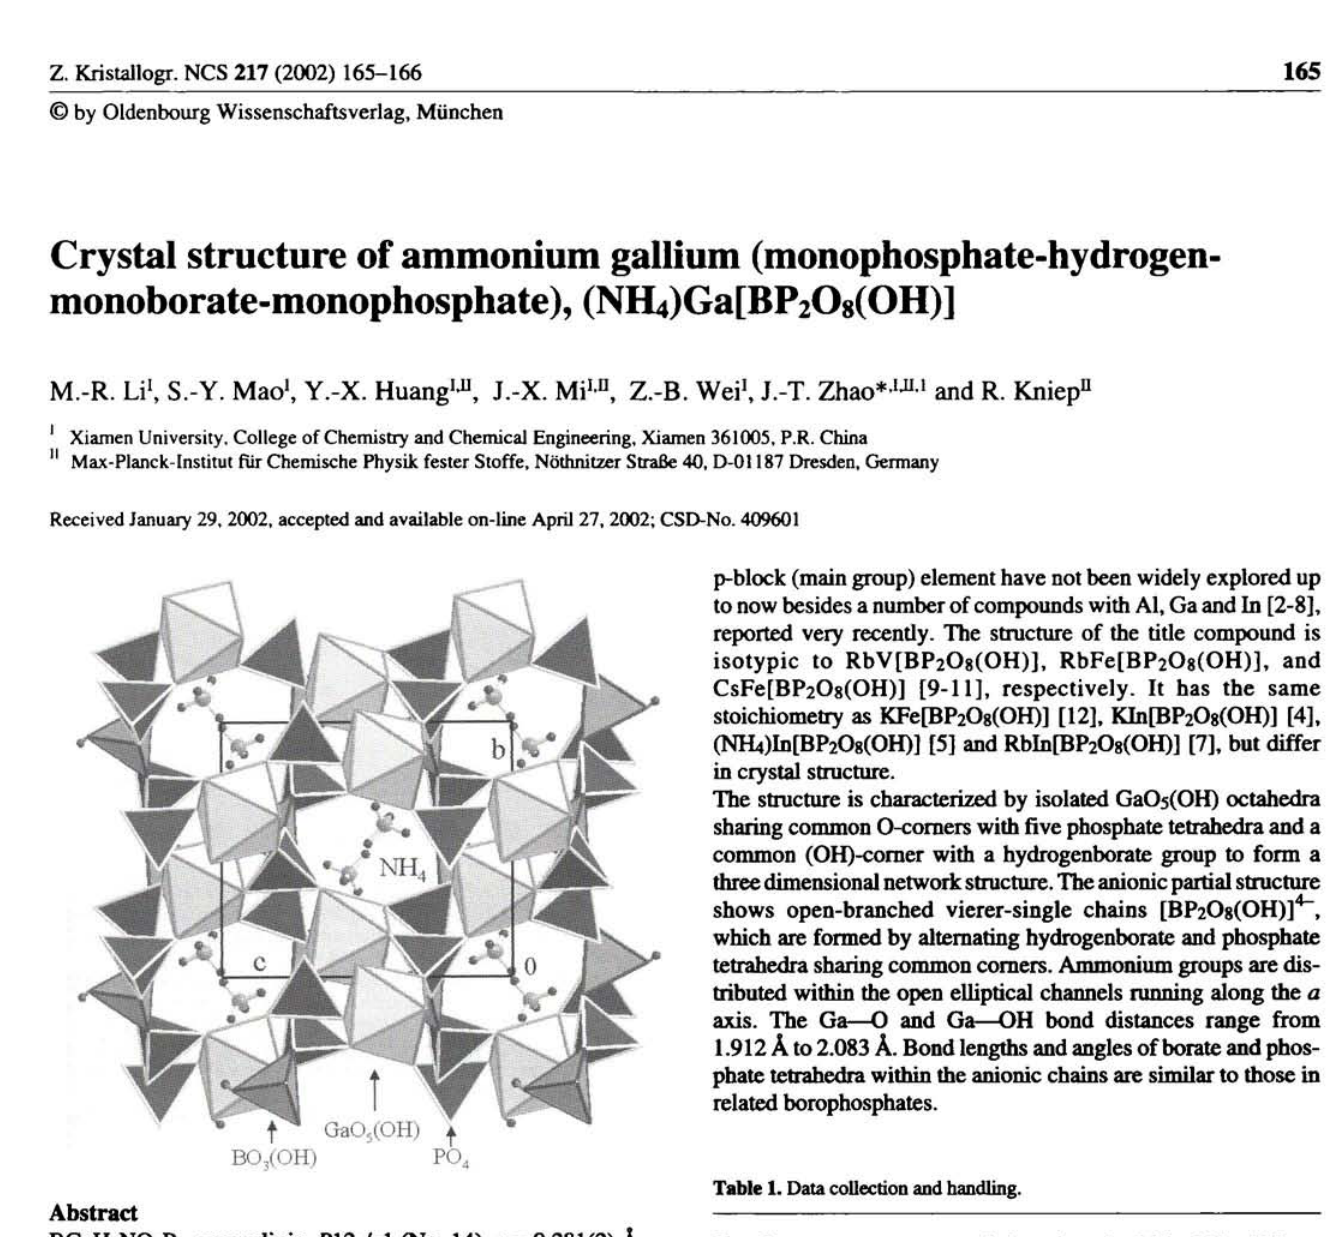
Table 1. Data collection and handling.